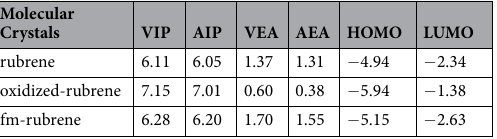
Molecular Crystals